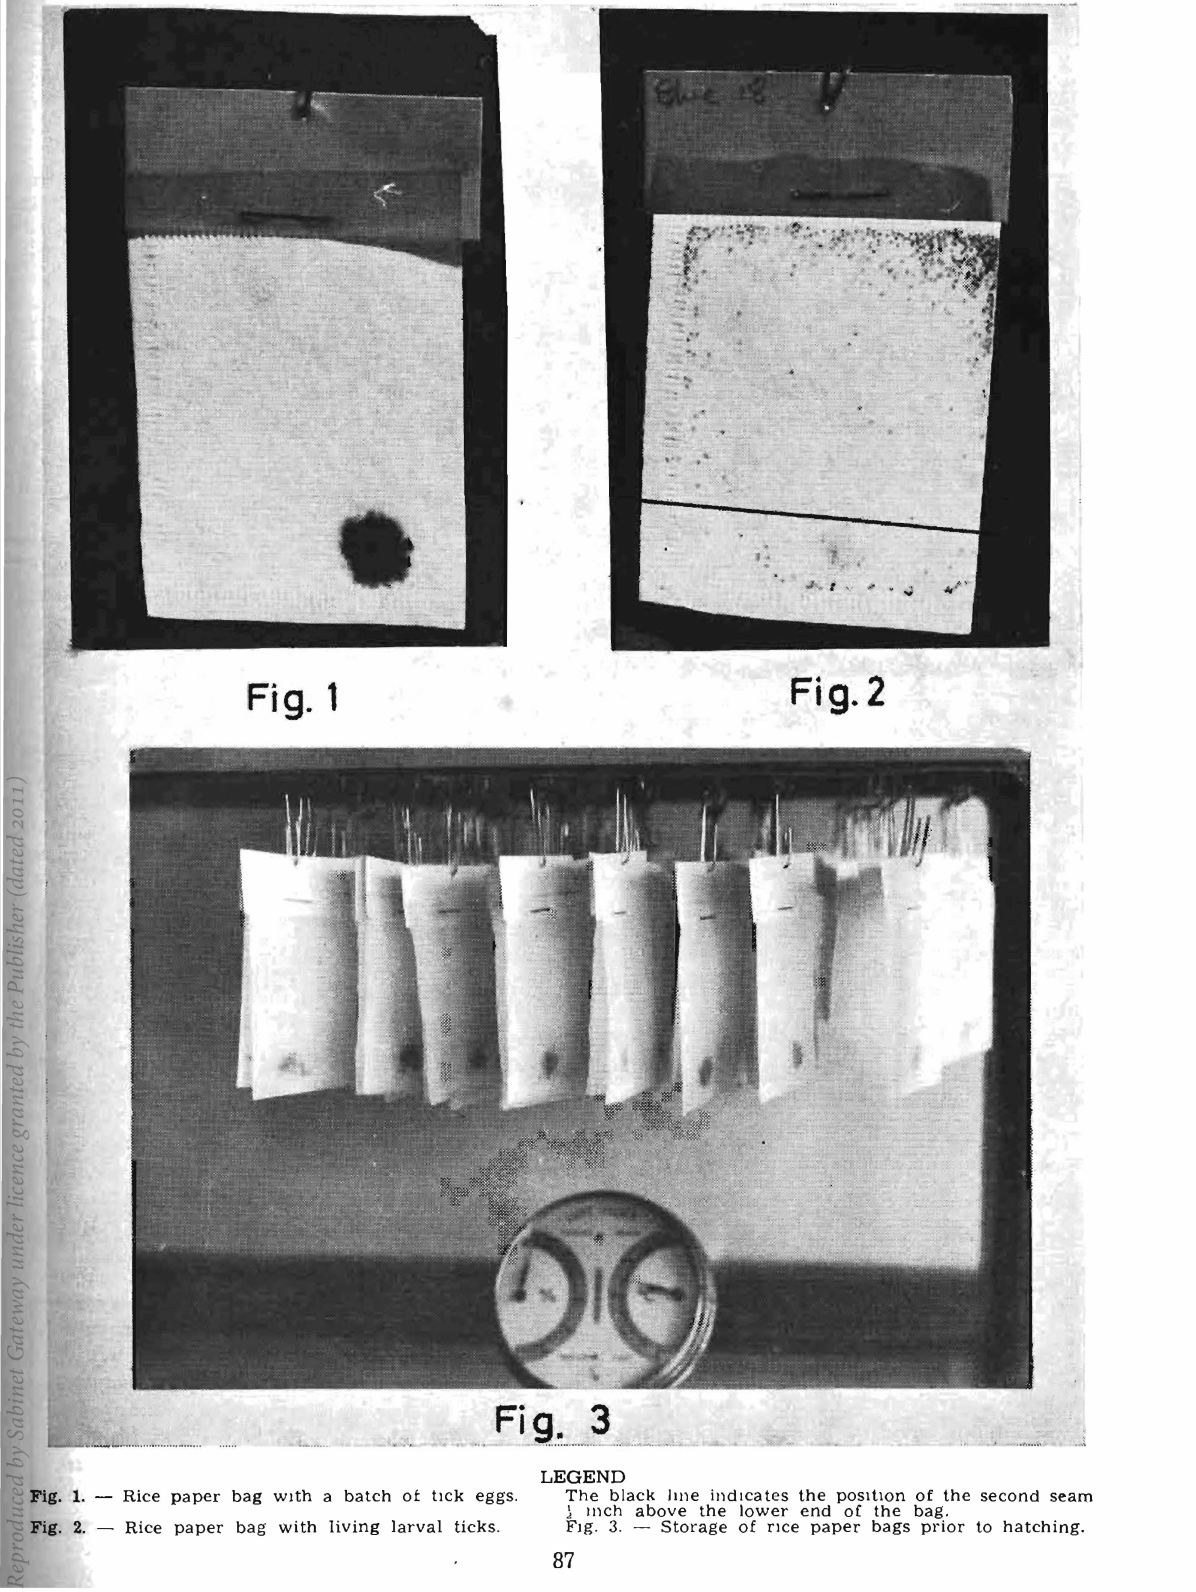
LEGEND The black lllle indicates the positIOn of the second seam ) Inch above the lower end of the bag. Fig. 3. - Storage of nee paper bags prior to hatching. 87